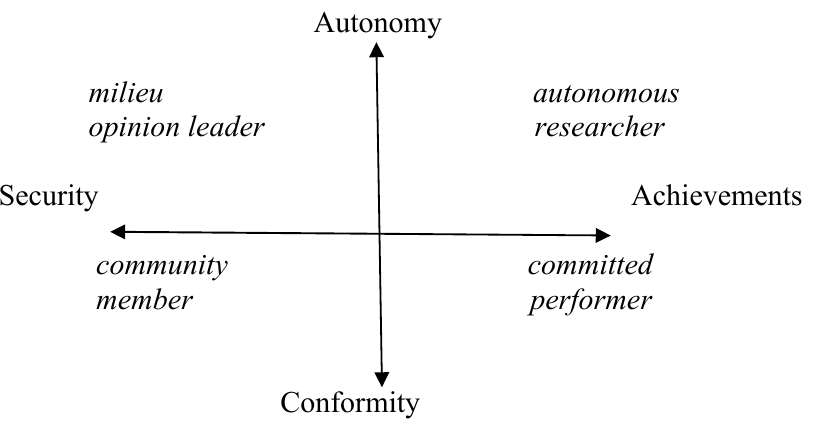
Figure 1. Typology of major orientations of young